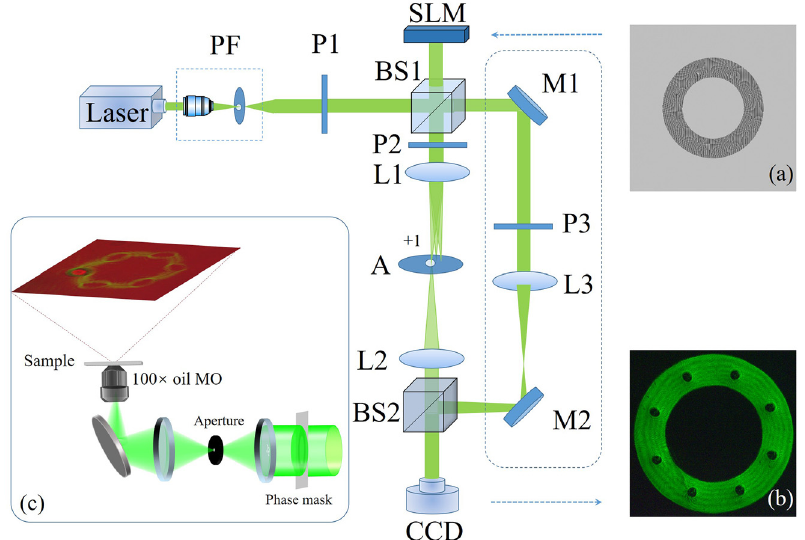
Figure 3: Schematic of the experimental setup. PF, pinhole filter; P1 – P3, polarizers; BS1 and BS2, beam splitters; SLM, spatial light modulator; L1 – L3, convex lenses; A, aperture; M1 and M2, mirrors; CCD, charge- coupled device. (a) Amplitude-modulated phase mask, (b) intensity of HO-OVL recorded by CCD,